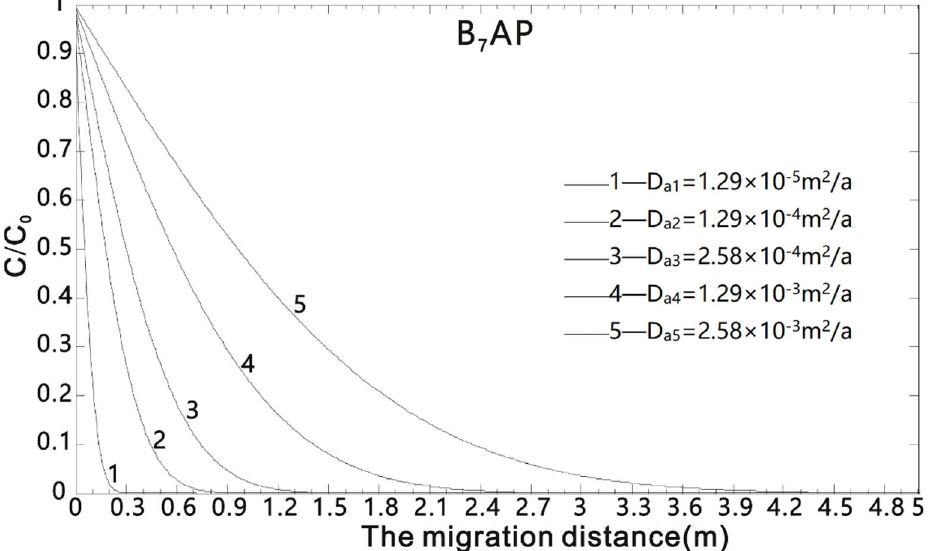
Figure 7. Effect of apparent diffusion coefficient on migration of uranium in B 7 AP buffer material (t = 1000a).